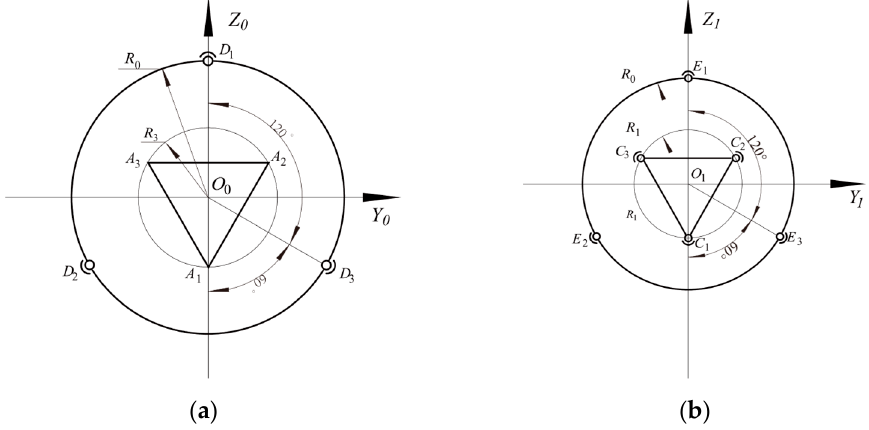
Figure 3. ( a ) The inertial frame on the base platform D ; ( b ) The moving frame on the moving plat- form m